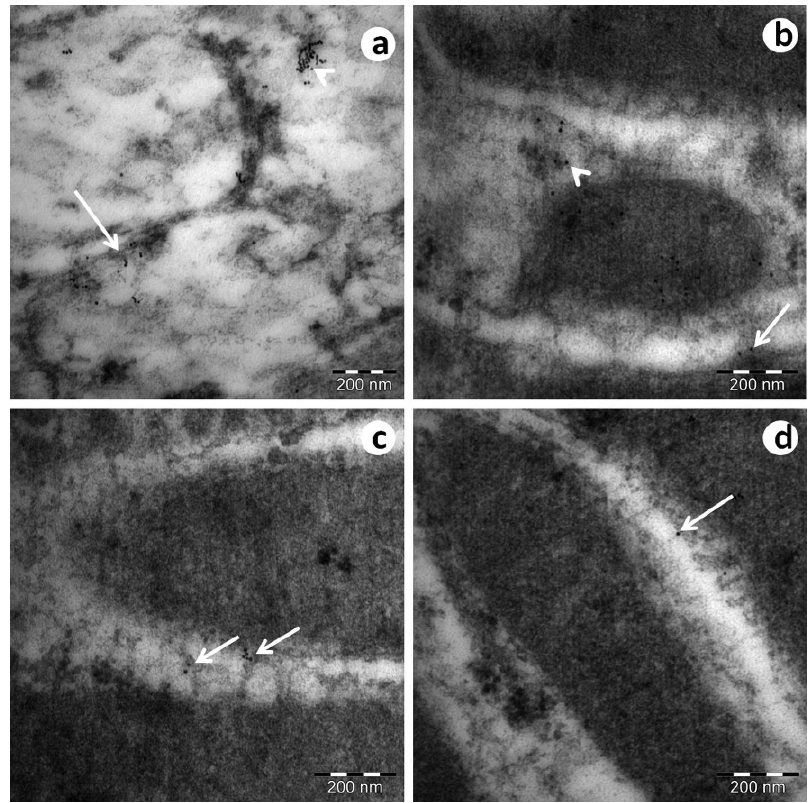
Figure 7 - The connexin-43 ultrastructural immunohistochemistry of a convoluted proximal tubule. Connexin-43 (Cx-43) immunostaining was observed in the space between the interdigitations (arrow) and in the cytoplasmic compartments of the endothelial cells (arrowheads) in the convoluted proximal tubules of the SED-WKY (a) and EX-WKY (b) control groups. The SED-SHR (c) and EX-SHR (d) groups showed decreased Cx-43 expression. Abbreviations: EX, exercised; SHR, spontaneously hypertensive rats; SED, sedentary; WKY,